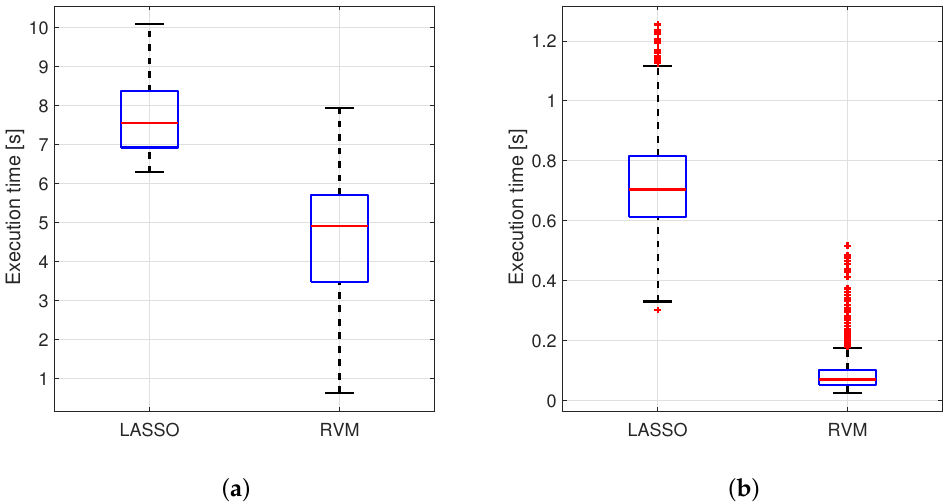
Figure 10. Examples of distributions of execution times in seconds for RVM and LASSO depending on MCCV iterations (1000). Arcene data in ( a ), and Fabric Care Appliance data ( b